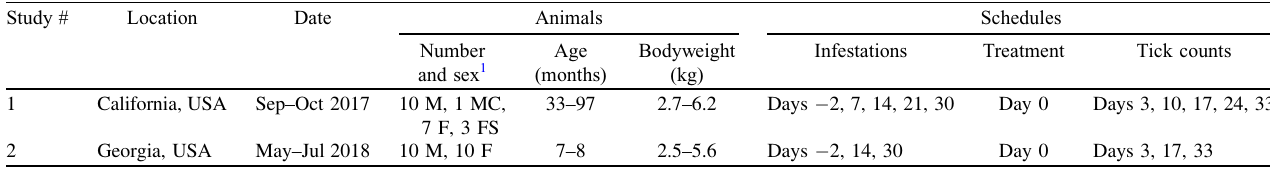
Table 1. Main differences between the two